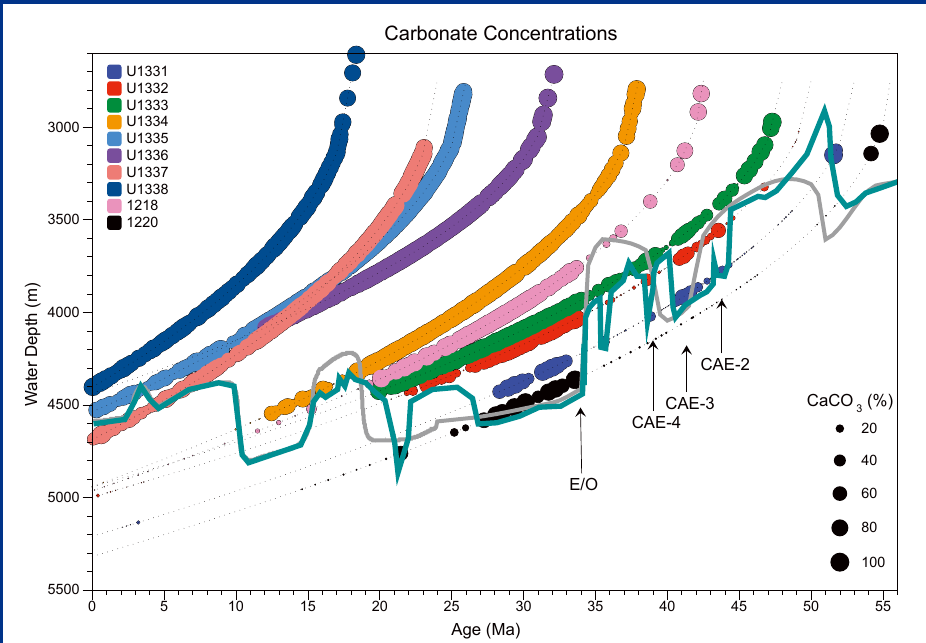
Figure 6. CaCO 3 % vs. depth and age from initial analysis of PEAT results. The carbonate compensation depth (CCD) through the Cenozoic is shown to be very dynamic during the Eocene, with many excursions of ~500 m. The Neogene has generally a deeper CCD and milder